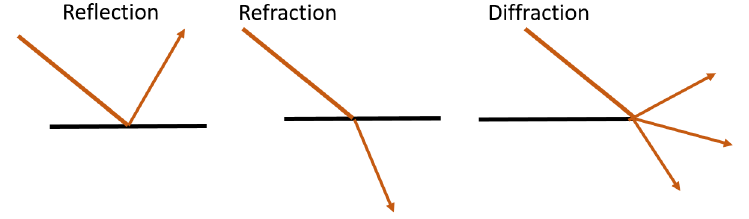
Figure 4. Signal propagation: reflection, refraction and